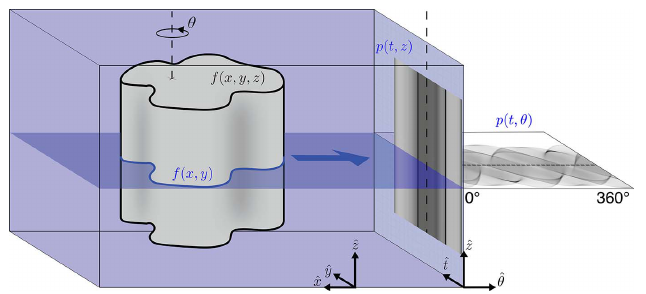
Figure 1 Parallel beam tomographic imaging of an object f ( x , y , z ) with a rotation axis in the ^ zz direction. X-rays moving from left to right pass through the object producing a projection image p ( t , z ) on the detector (grid on far right). The object is rotated and imaged iteratively, producing the full tomographic data set p ( t , (cid:2) , z ). The vertical dashed lines indicate the location of the axis of rotation in each of the three domains. If the axis of rotation is aligned with the ^ zz axis, we can reconstruct 2D slices of the object f ( x , y ) at z from sinograms p ( t , (cid:2) ) at z